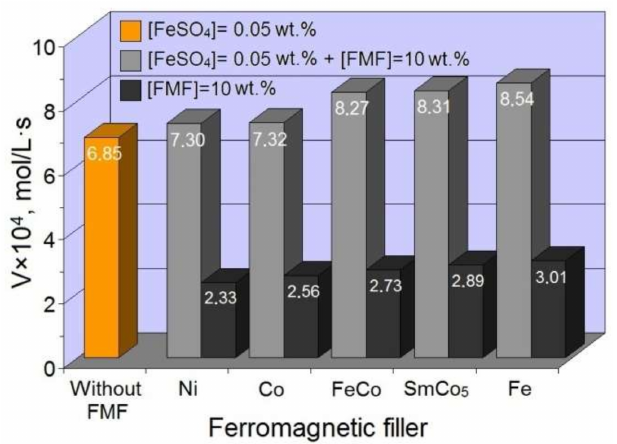
Figure 1. Effect of FMF nature on the initial polymerization rate of HEMA/PVP compositions (HEMA:PVP = 80:20 mass parts).